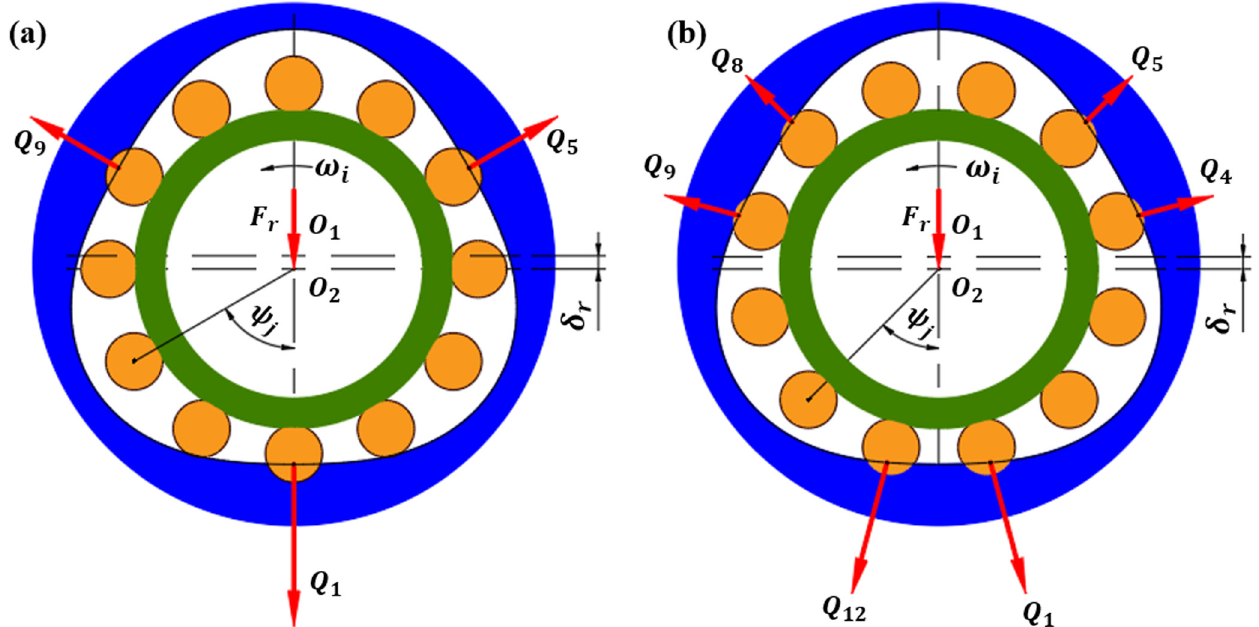
Fig. 3. Preload distribution of the cylindrical roller bearing with triple-lobe raceway after loading: (a) single-pressed state; (b) double- pressed state.